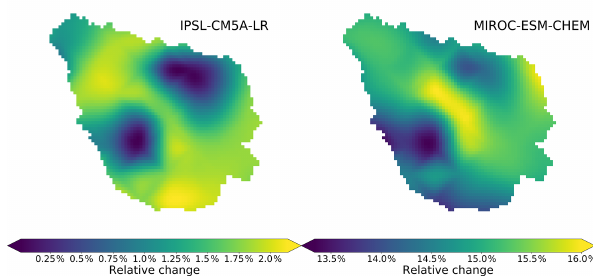
Figure 8. Spatial distributions of relative change in diffuse recharge using two different GCMs under 1.5 ◦ C warming. This figure indi- cates varying spatial organizations of diffuse recharge change for different